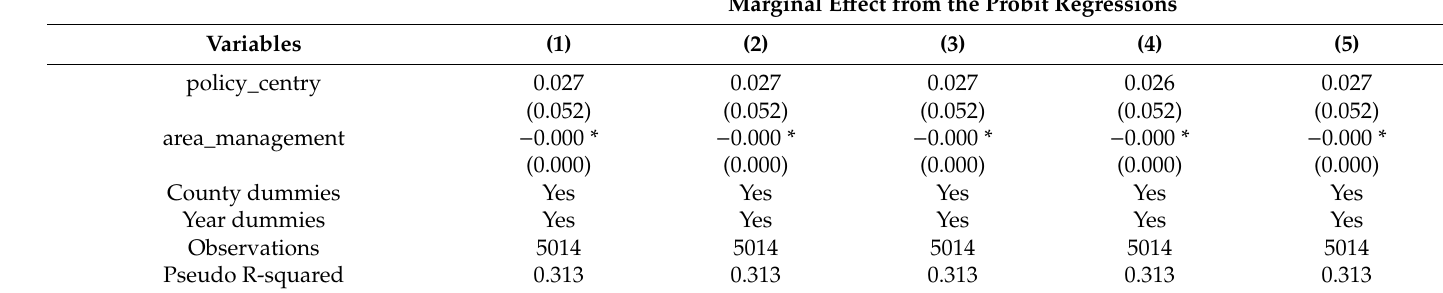
Table 10. Cont. Marginal E ff ect from the Probit